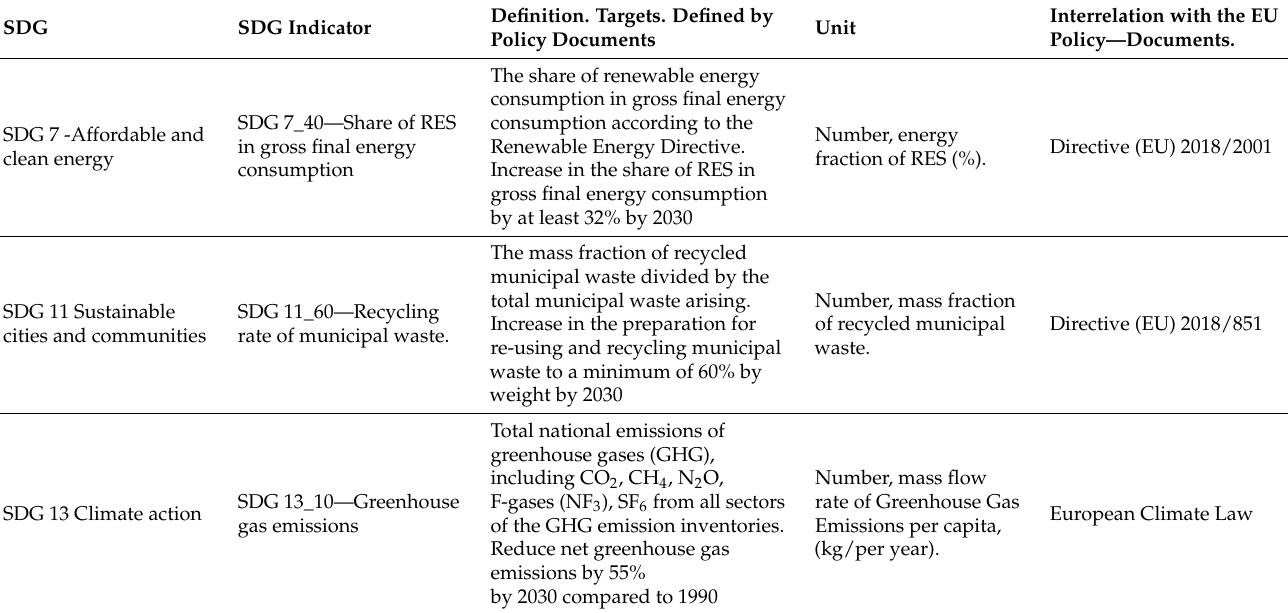
Table 1. SDG indicators of the environmental area in the context of EU policy targets. Definition. Targets. Defined by Policy Documents